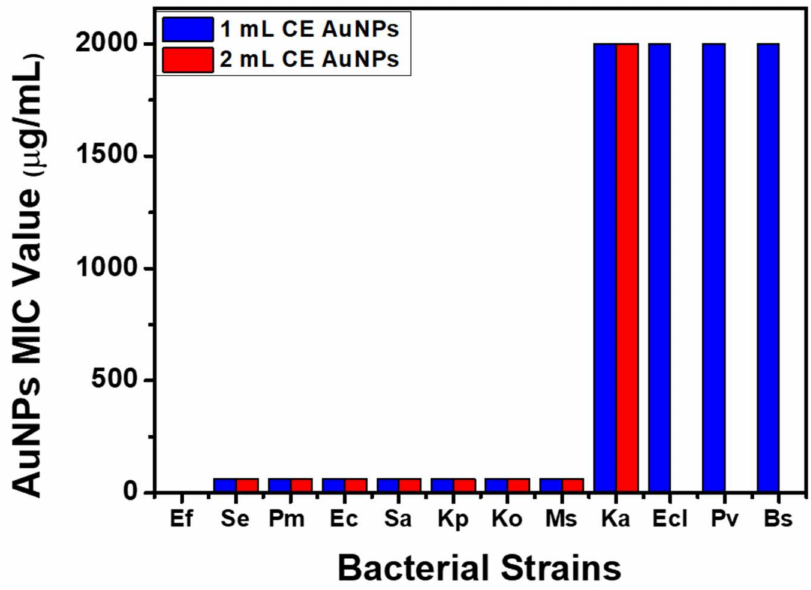
Figure 7. MIC Values of AuNPs using 1 mL and 2 mL of CE.